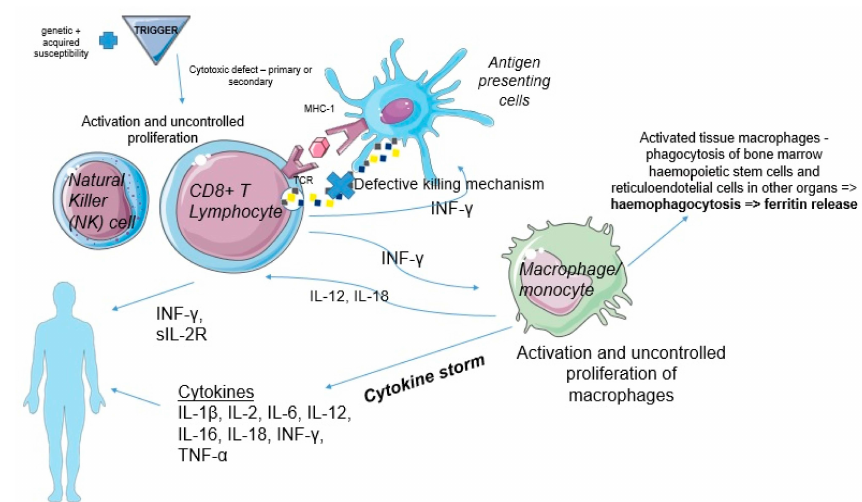
Figure 2. Pathogenesis of HLH. The macrophages become active and see uncontrolled proliferation through various mechanisms. This causes them to release a variety of pro-inflammatory cytokines which are involved in the further amplification effects of HLH. Of note, we can mention INF- γ , IL-1 and IL-6, which are known pro-inflammatory cytokines. Moreover, through IL-12 and IL- 18, macrophages also have an effect on cytotoxic T-lymphocytes, activating them and creating a vicious